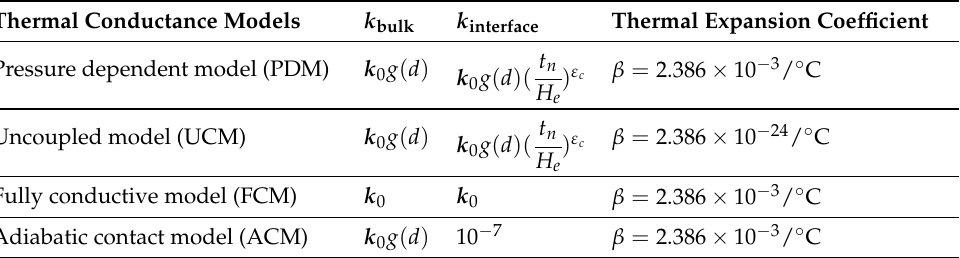
Table 1. Four different thermal conductance models with different settings of thermal conductivity k and thermal expansion coefficient β